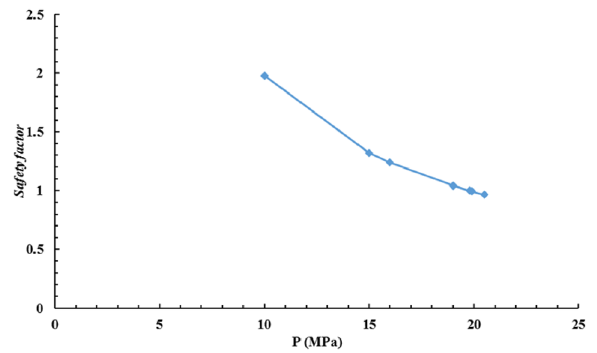
Fig. 5 Investigation of the burst pressure of the 2-D Finite element model